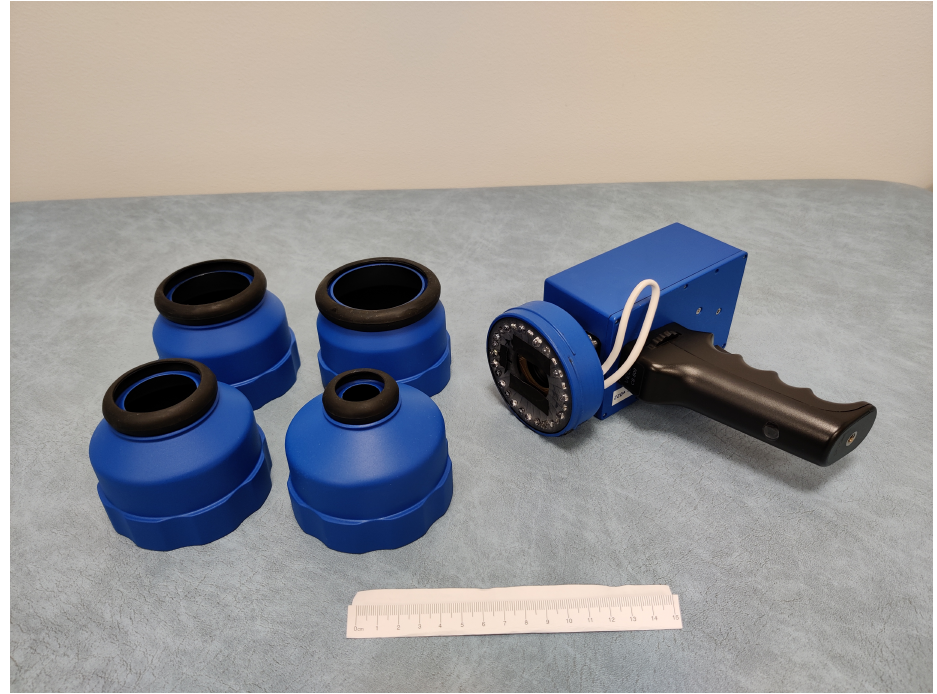
Figure 1. SICSURFIS spectral imager with integrated LED module and stray light protection